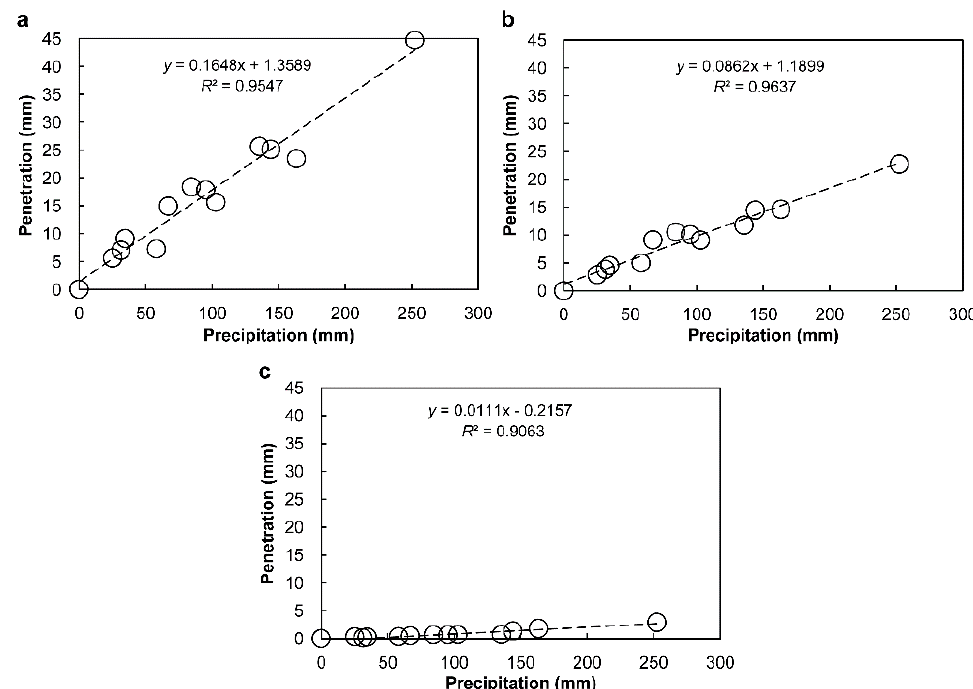
Figure 5. Amount of groundwater penetration compared to the monthly precipitation of the three ground materials: ( a ) regression equation for the vegetation area (Va) penetration; ( b ) regression equation for the permeable sidewalk (Ps) penetration; ( c ) regression equation for the some pervious sidewalk (SPs) penetration.